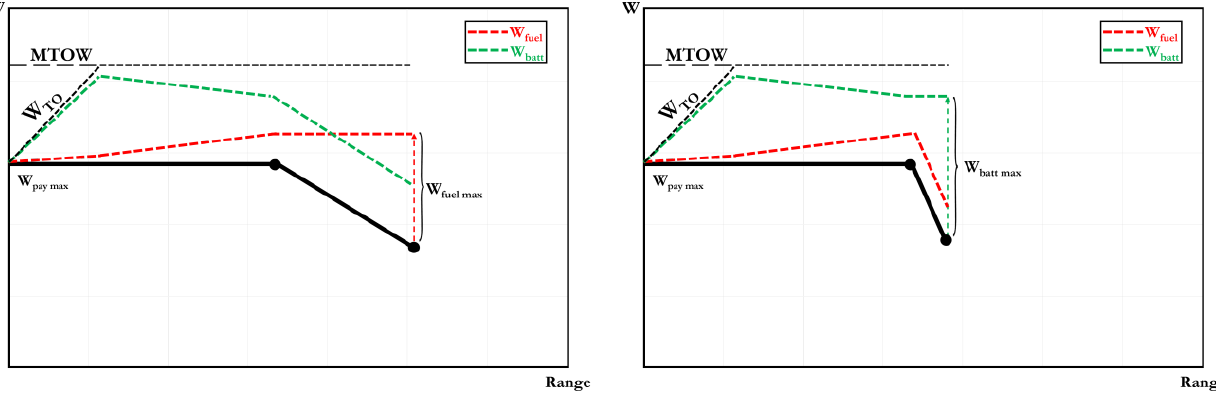
Figure 18. Strategies to extend the range beyond the design point: mass exchange between payload and fuel (left), and between payload and batteries (right).